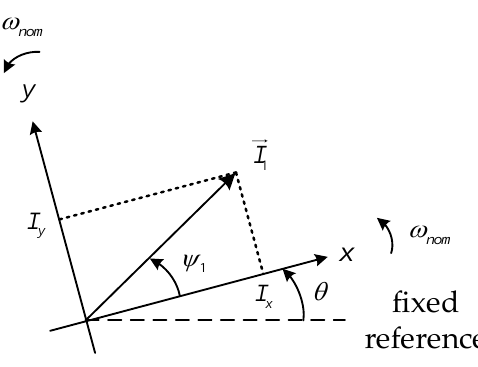
Figure 3. Reference axes involved in the phasor extraction.